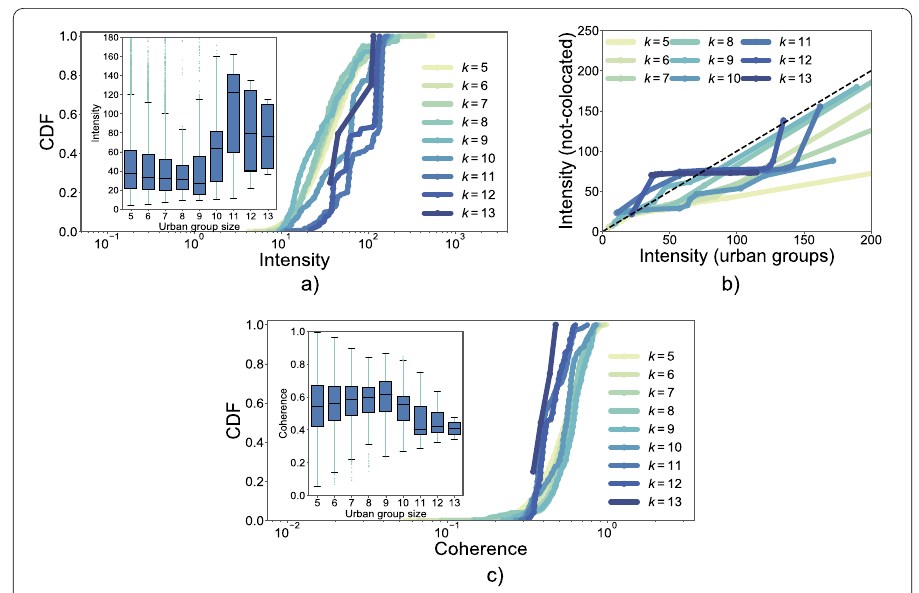
Figure 4 Intensity and coherence. In ( a ) the distribution of the intensity int for k = 5, ... ,13. The x -axis is logarithmic and the y -axis is linear. In the inset figure, the box and whisker plots of the intensity as a function of the urban group size. Boxes span the 1–3 quartile interval and the whiskers indicate the boundaries after which data are outliers. In ( b ) the qq-plot between the distribution of intensity evaluated on urban groups ( x -axis) and not-colocated cohesive groups ( y -axis). The dotted black line indicates the theoretical trend in case of equality of the distributions. The points represent 0.1 equally spaced quantiles. In ( c ) the distribution of the coherence coh for k = 5, ... ,13. The x -axis is logarithmic and the y -axis is linear. In the inset figure, the box and whisker plots of the coherence as a function of the urban group